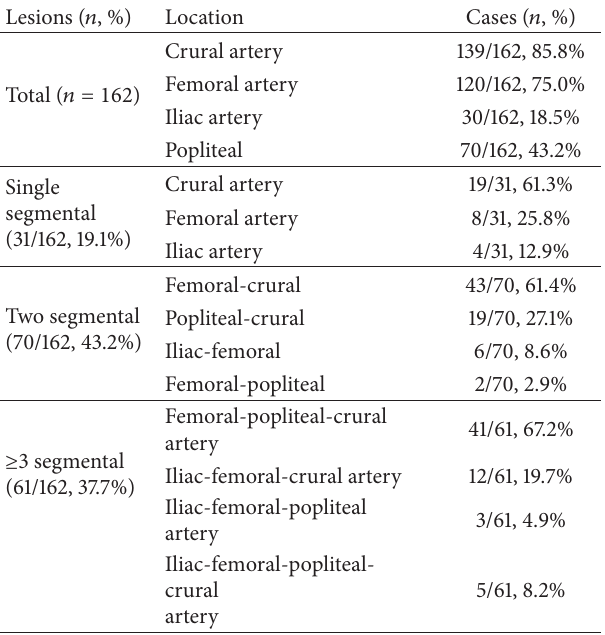
Table 2: Location of the lower limb artery lesion in 162 diabetic